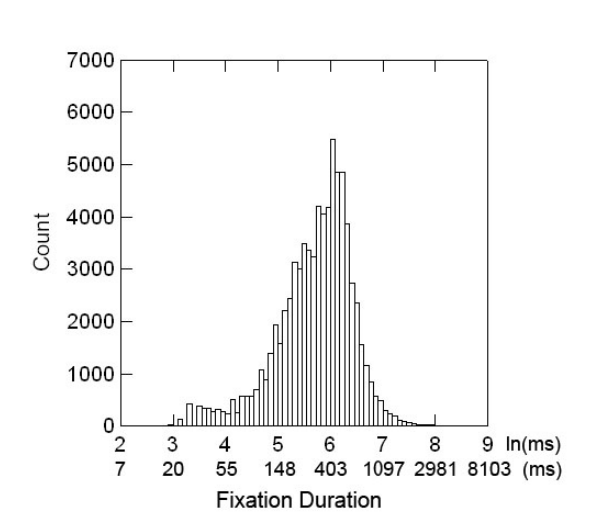
Figure 2. Distribution of fixation durations Fixation duration distribution across all conditions in natural- logarithmic time units (upper x-axis) and ms (lower x-axis). The median of the distribution is 5.83 in ln ms, or 340